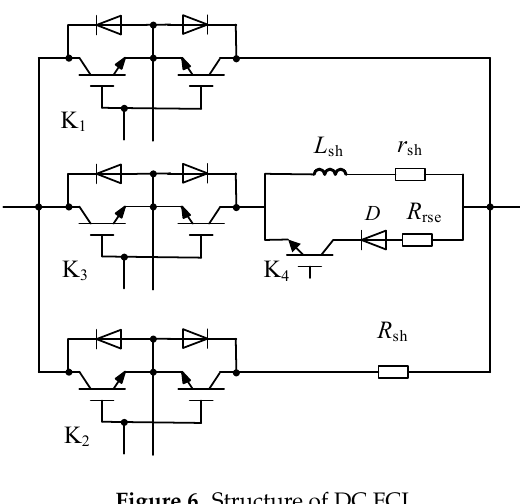
Figure 6. Structure of DC FCL.